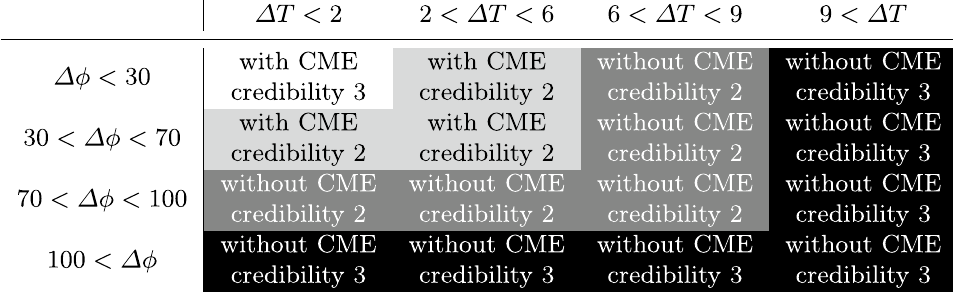
Table 1 Criteria for determining the credibility of a CME association on the basis of ∆ T and ∆φ